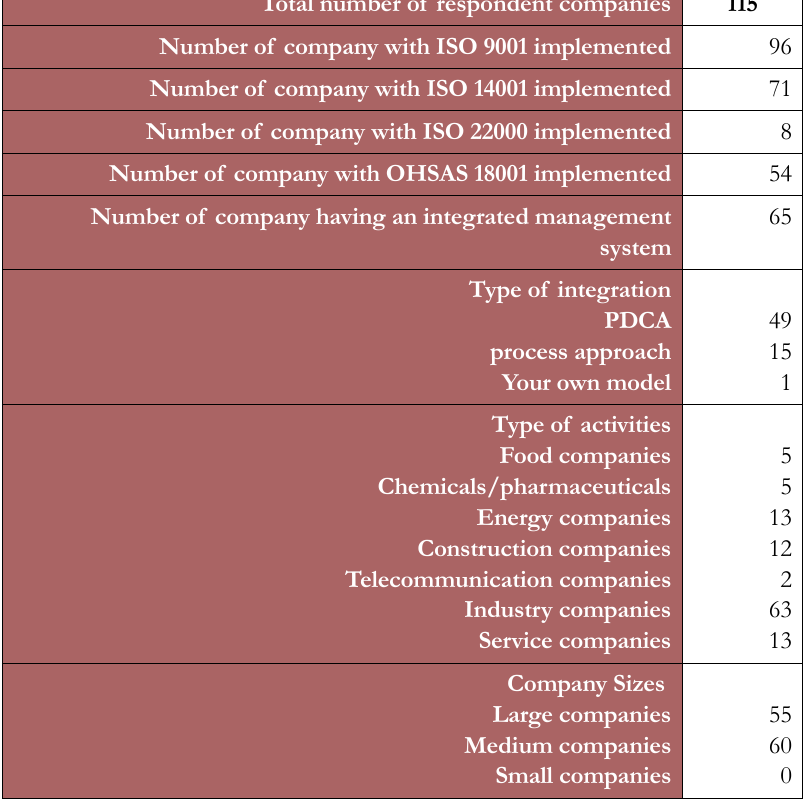
Table 2. General information of